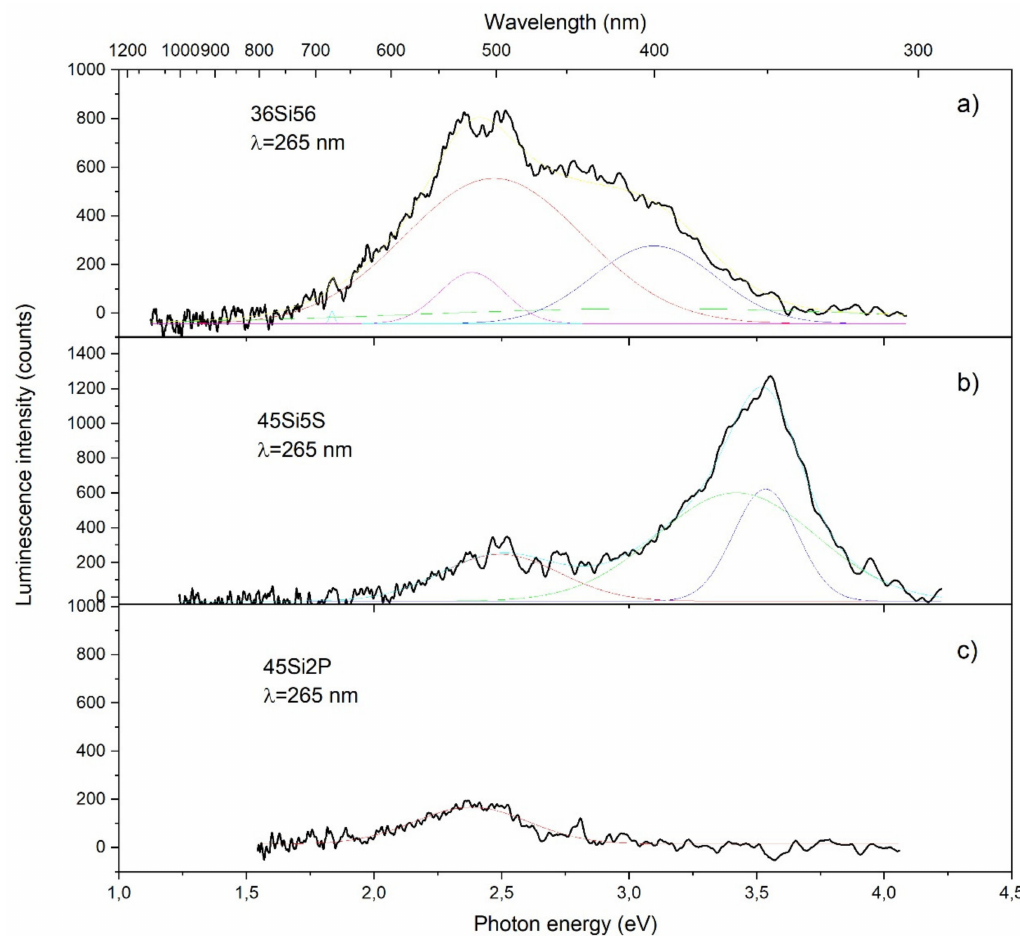
Figure 15. Luminescence spectra for the 36Si11P5S ( a ), 45Si2P5S ( b ) and45Si2P ( c ) glass samples with